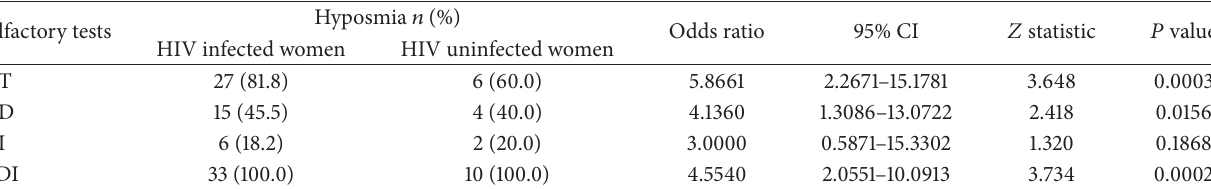
Table 4: Types of olfactory dysfunction in the participants.